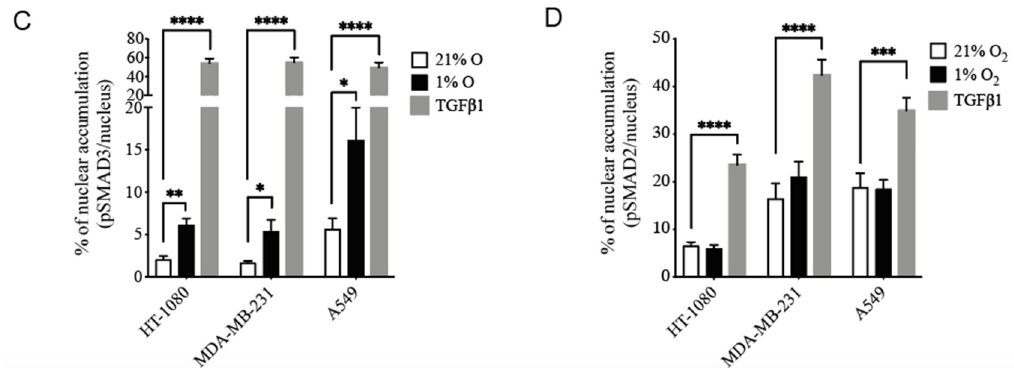
Figure 1. Hypoxia Selectively Increases Nuclear Accumulation of pSMAD3 in Different Cancer Cell Lines. ( A , B ) Representative confocal microscopy images of HT-1080, MDA-MB-231 and A549 cells incubated under normoxic (21% O 2 ), hypoxic (1% O 2 ) or TGF β -supplemented conditions, stained with DAPI (blue) and anti-pSMAD3 (Ser423/425) ( A ) or anti-pSMAD2 (Ser465/467) ( B ) antibody (green). Scale bar = 10µm. ( C , D ) Graphs showing the percentage of nuclear accumulation of pSMAD3 ( C ) or pSMAD2 ( D ) in HT-1080, MDA-MB-231 and A549 cells cultured under normoxic, hypoxic or TGF β 1-supplemented (1 ng/mL) conditions. ( n = 3–5, 10 cells per group per experiment). Data are presented as mean ± SEM. * p < 0.05; ** p < 0.01; *** p < 0.001 and **** p < 0.0001.